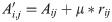
Accuracy as a function of noise levels for datasets Leukemia (k = 2), Leukemia (k = 3), CNS (k = 4) and Medulloblastoma (k = 2) respectively.For each noise level μ, NMFs are run 100 times on disturbed matrices. On each of such runs, a disturbed matrix A′ is generated by adding independent uniform noises: Ai,j′=Aij+μ*rij, where rij is a random number generated by a uniform distribution on the interval [0, max], and max is the maximum expression in A. Plotted is the mean of clustering accuracies from 100 runs together with an error bar representing a standard error of the mean. The post-processing method uses the maximum norm together with the filter.